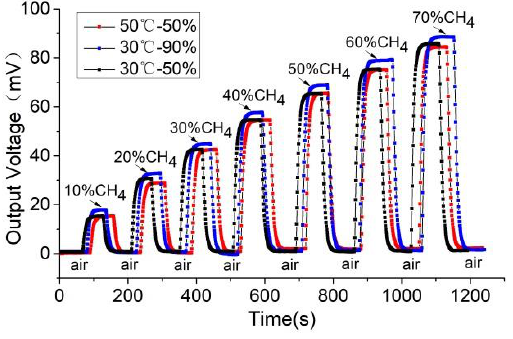
Figure 9. Response-recovery curves of the thermal conductivity sensor under different temperatures and humidity.